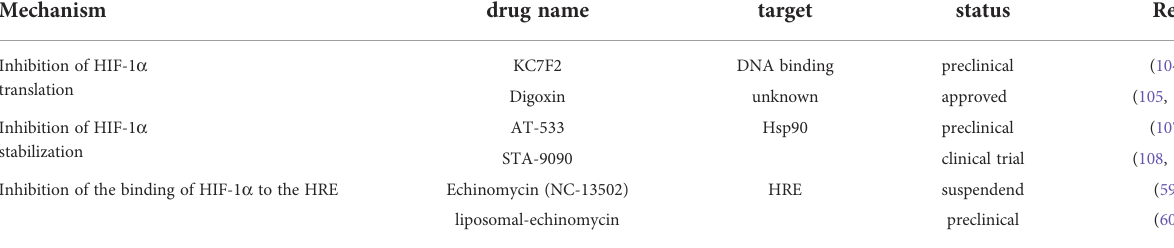
TABLE 1 Overview of drugs that inhibit HIF-1 activity reported in breast